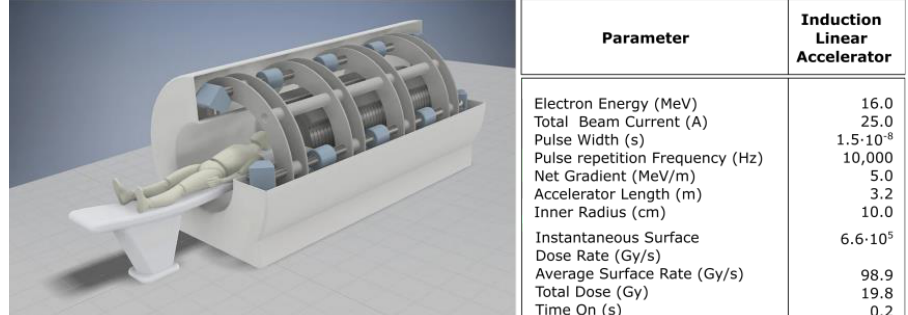
Figure 11. Concept FLASH-RT system using a linear induction accelerator (LIA) providing four or more lines of sight. LIA is on axis with the patient. Blue components are the magnetic focusing elements that direct the electron beam to the patient. The active accelerator is 3.2 m. With the returning drift section, the overall system length is 3.5 m less the patient couch [121]. (Sampayan, S.E.; et al., Sci. Rep. 2021, 11, 17104, https://doi.org/10.3389/fonc.2019.01563, reproduced with permission under the terms of the Creative Commons Attribution License (CC BY), http://creativecommons.org/licenses/by/4.0/).